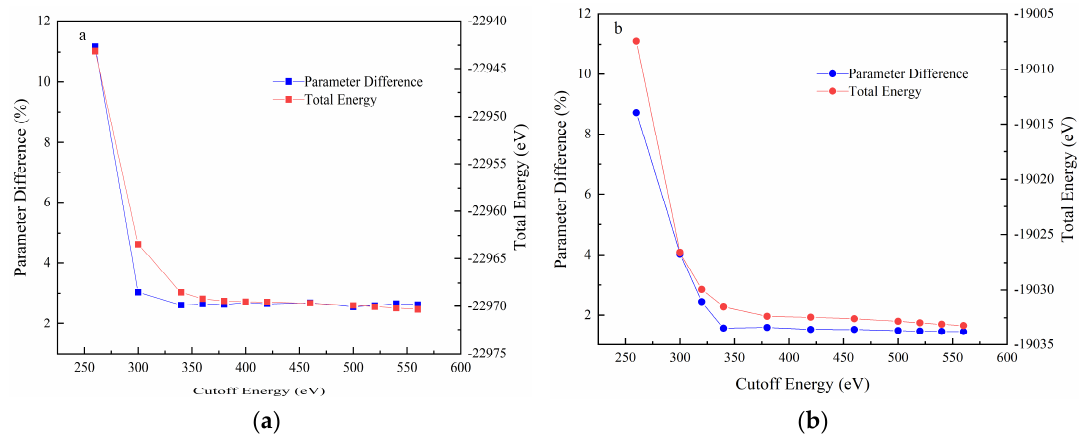
Figure 2. Total energy and lattice parameter difference as a function of kinetic cutoff energy with the k-point mesh of 3 × 2 × 4 for hemimorphite ( a ) and 4 × 4 × 2 for smithsonite ( b ).